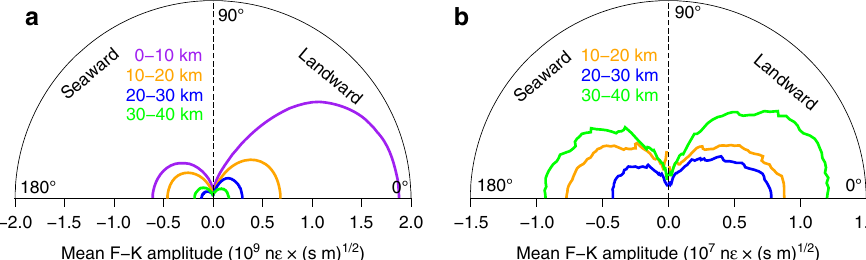
−2.0 −1.5 −1.0 −0.5 0.0